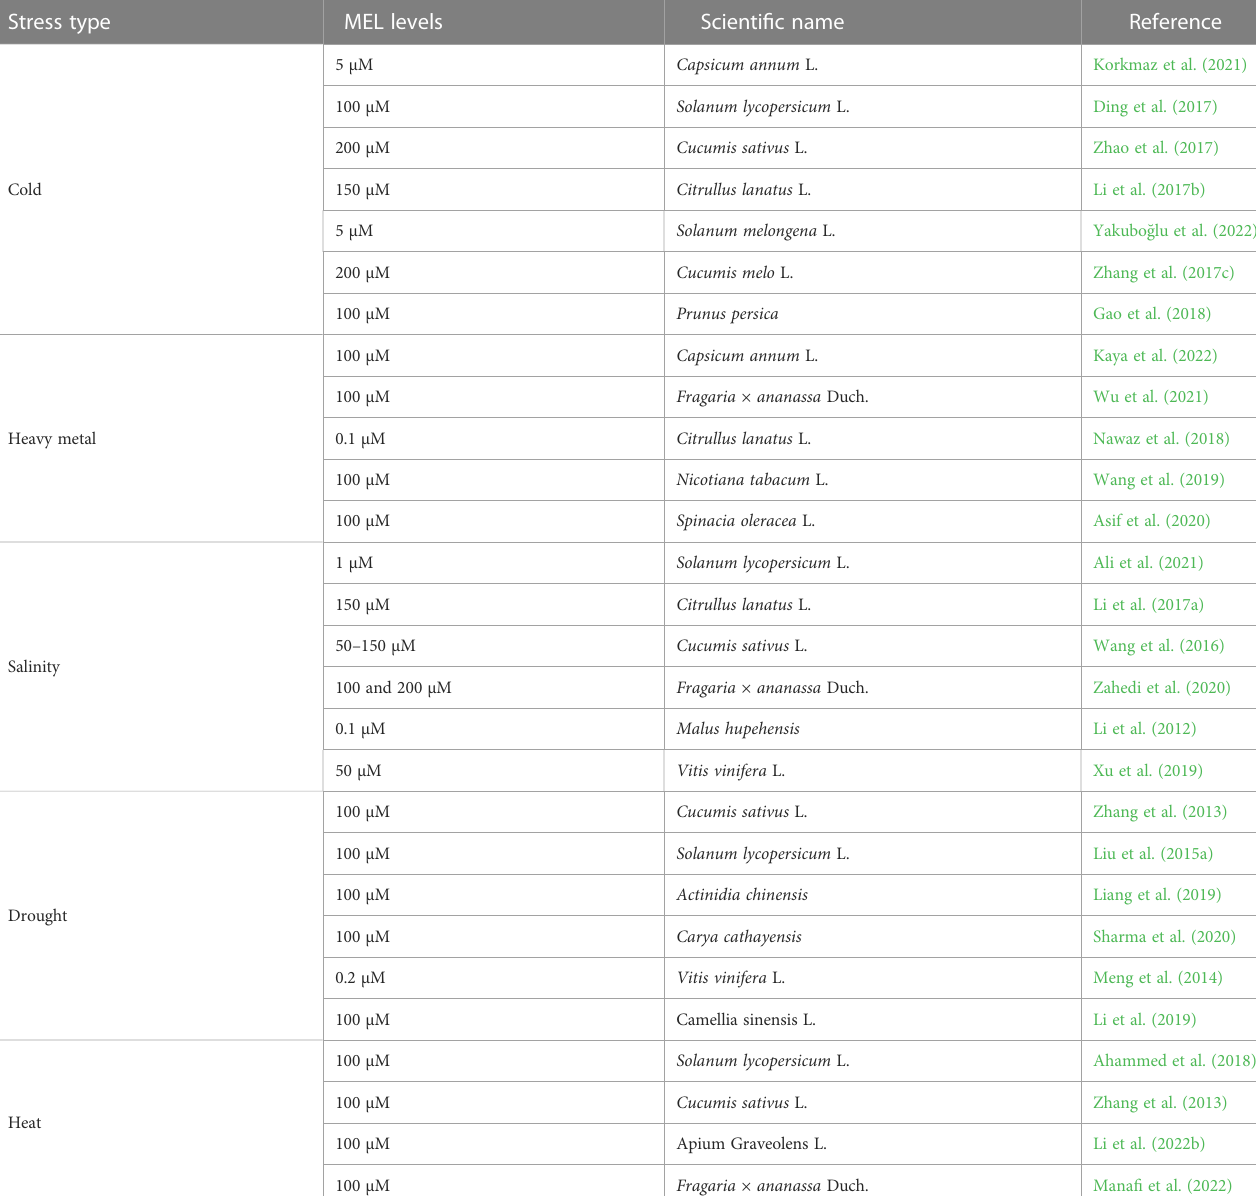
TABLE 1 Exogenous melatonin enhanced abiotic stress tolerance in horticultural